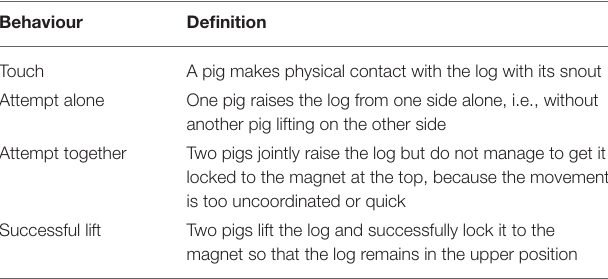
TABLE 1 | Ethogram to record the behavioural interactions with the joint log-lift task